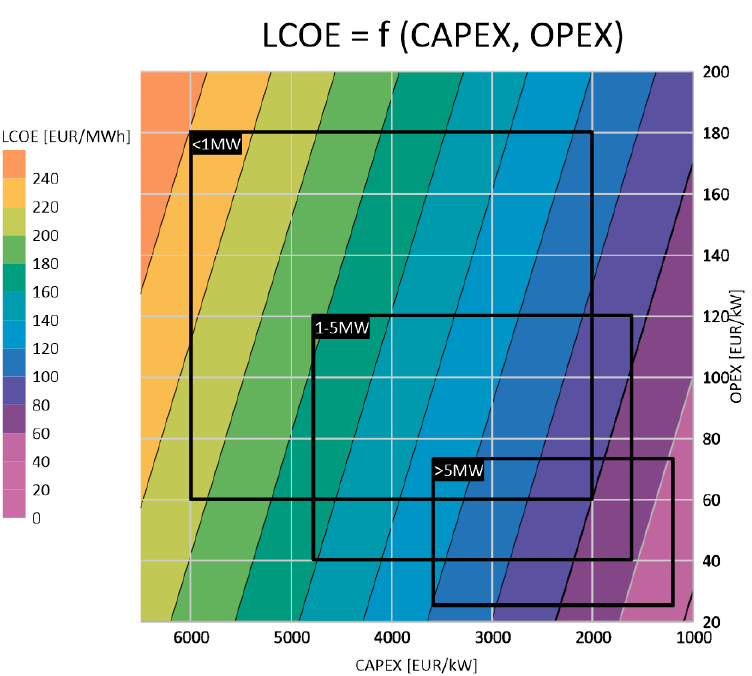
Figure 2. The total cost LCOE–WACC rate of 7% and life time 15 years. Source: own elaboration. As shown in the chart above, the LCOE values are about two times higher than previous. In this case, the medium hydropower plants mostly reach LCOE around EUR 100/MWh. Small and micro hydropower plants can achieve LCOE values of EUR 100–200/MWh—their CAPEX and OPEX ranges defined by the respective black boxes are almost in the blue and green fields. The next figure (Figure 3) presents LCOE calculations for higher WACC value (11.4%) and two analysis periods (15 and 50 years).